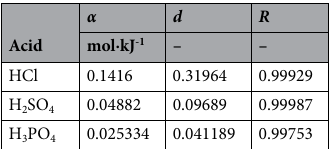
Table 3. Optimal adjustable parameters ( α and d ) from linear regression of Eq.